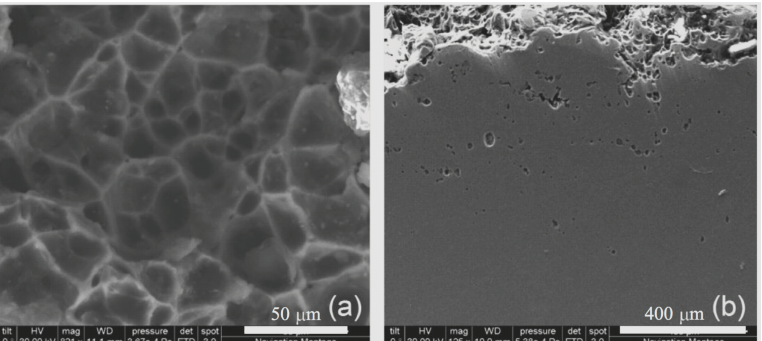
Figure 10. SEM micrographs of the 1100-O aluminum shock compressed to 6 GPa showing ( a ) dimples on the fracture surface and ( b ) the cross-sectional view of the fractured sample showing voids below the spall plane [149].